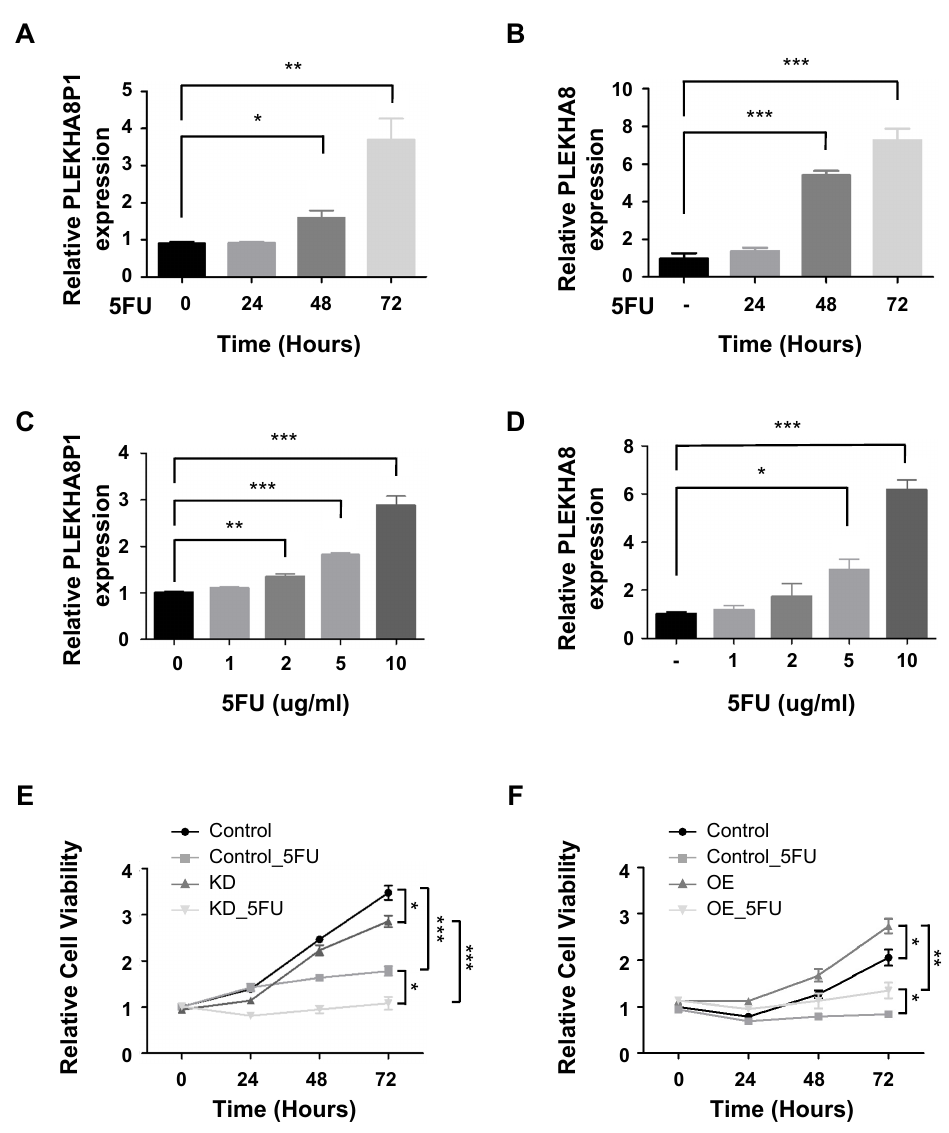
Figure 6. Downregulation of PLEKHA8P1 sensitizes HCC cells to 5-FU. ( A – D ) qRT-PCR was carried out to determine the expression levels of PLEKHA8P1 and PLEKHA8 in 5-FU-treated cells. ( A , B ) Cells were treated with 5-FU (10 µ g/mL) for the indicated time (0, 24, 48, 72 h). ( C , D ) Cells were treated with indicated concentrations (0, 1, 2, 5, 10 µ g/mL) of 5-FU for 72 h. ( E ) FT3-7 cells were transfected with ASOs and cell viability assays were conducted in the presence or absence of 5-FU (10 µ g/mL). ( F ) FT-3-7 cells were transfected with PLEKHA8 plasmid and cell viability assays were conducted in the presence or absence of 5-FU (10 µ g/mL). All data were acquired from three independent experiments and p -values were determined by two-tailed unpaired t-test analysis. * p < 0.05; ** p < 0.01; *** p <